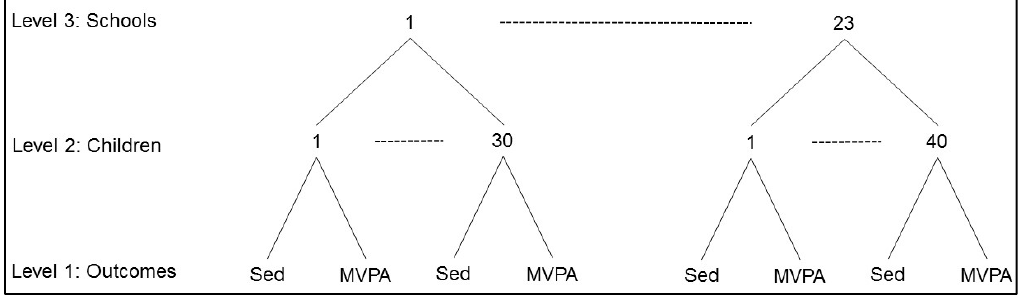
Figure 1. Multivariate multilevel structure of outcome variables (sedentary time (Sed) and moderate-to-vigorous physical activity (MVPA)) at level 1, nested within children at level 2, nested within schools at level 3.